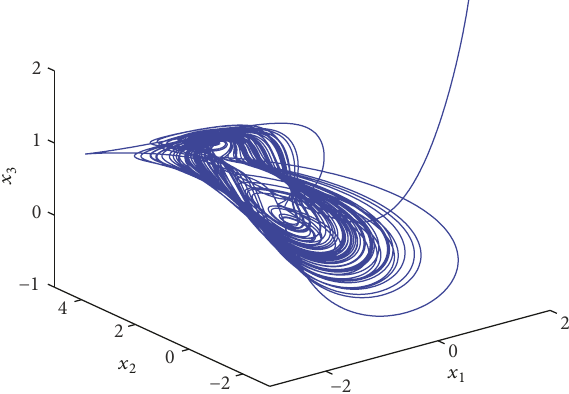
Figure 1: Three-dimensional phase diagram of fractional-order financial system